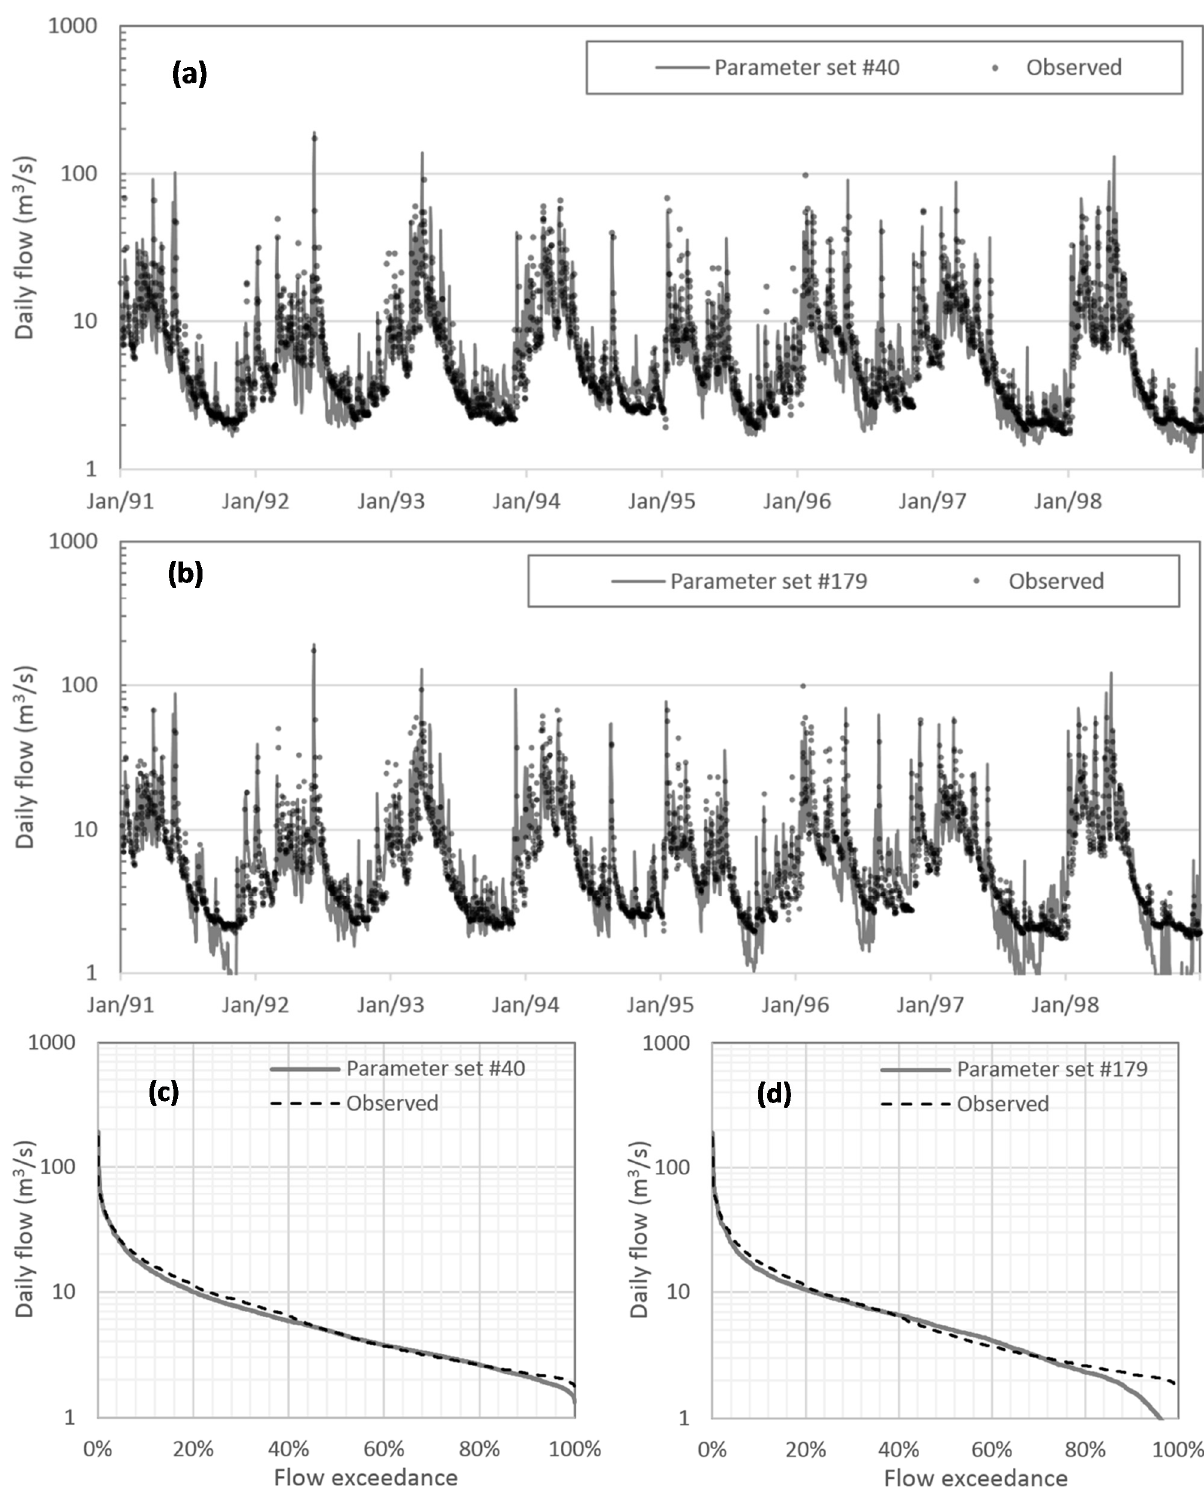
Figure 5. Comparison of the observed and simulated daily hydrographs with parameter set No. 40 ( a , c ) and No. 179 ( b , d ) for the Reed Creek watershed; ( a , b ) are daily log-scale hydrographs; and ( c , d ) are flow duration curves of daily